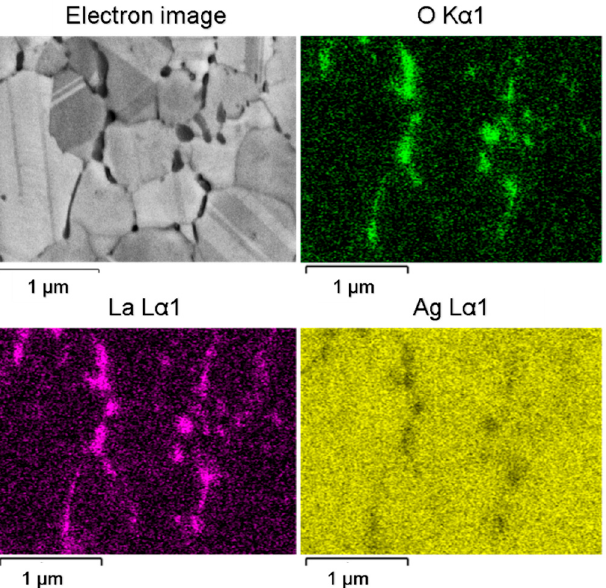
Figure 9. Micrograph of the chemical mapping of an internally oxidised microstructure with detection of the elements Ag, O and La.